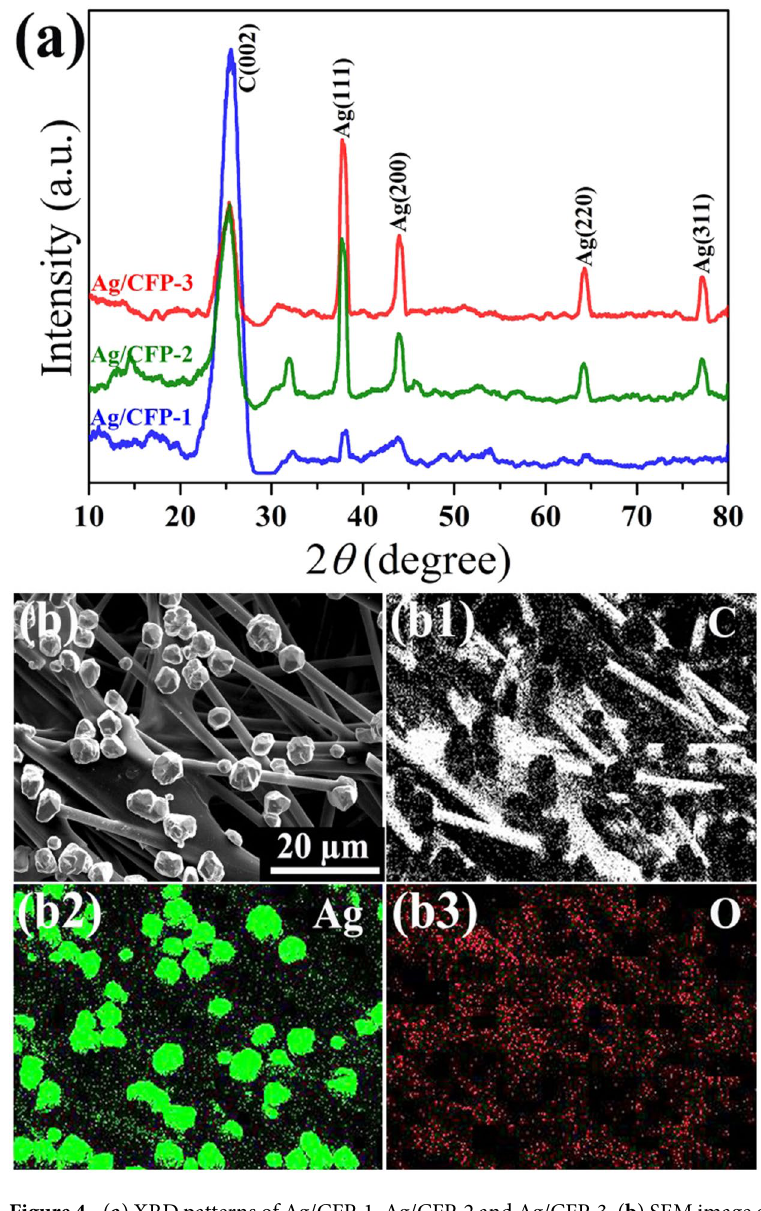
Figure 4. ( a ) XRD patterns of Ag/CFP-1, Ag/CFP-2 and Ag/CFP-3. ( b ) SEM image of Ag/CFP-3 used for elemental mapping analysis, (b1) C map, (b2) Ag map and (b3) O